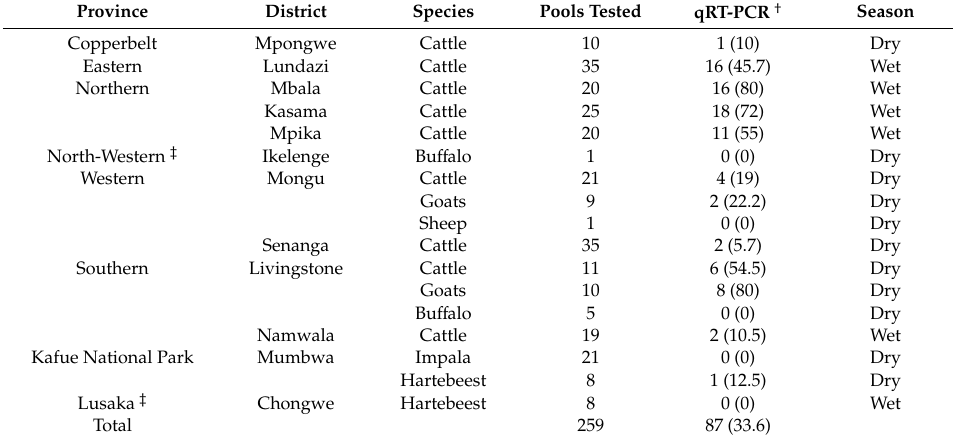
Table 2. Bluetongue virus nucleic acid detection results in pooled blood from domestic and wild ruminants in selected provinces of Zambia.